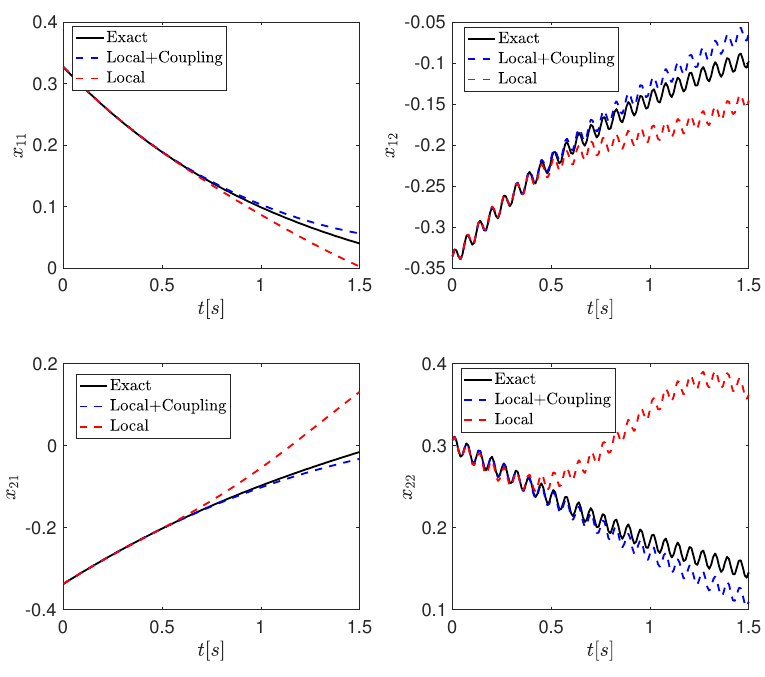
Figure 3. Comparison between the linear predictor and the original system—subsystem 1 ( top ) and subsystem 2 ( bottom ).